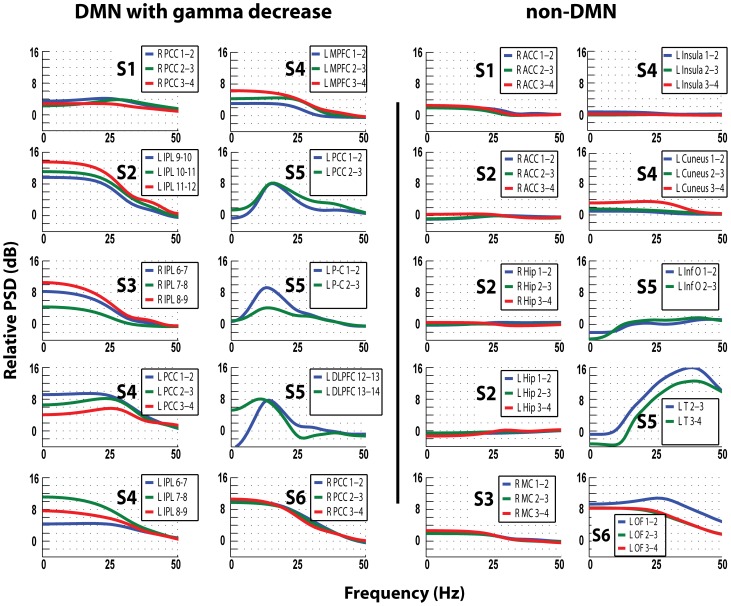
Relative power spectral density in dB, for frequencies 0–50 Hz.Power spectra in the DMN regions with gamma decrease and the non-DMN regions in all patients comparing 1 s epochs at the center of IED to baseline. Blue trace is the most medial, followed laterally by the green and red traces. S1–S6 relates to patients 1–6. Note the power increase in frequencies <30 Hz in all DMN regions with gamma decrease, but only in 2/10 non-DMN locations: Temporal cortex in patient 5 shows increase in low frequencies, secondary to propagation of epileptic activity (Fig. 1B), and LOF contacts of patient 6 also due to propagation of IEDs originating from left SMA (not shown). Comparing Fig. 4 and 5 shows an inverse relationship between the decrease in gamma and the increase in the lower frequencies in many DMN nodes: contacts that showed more gamma decrease also had more increase in lower frequencies: For examples, compare the responses in L PCC in patient 4 and L P-C in patient 5.